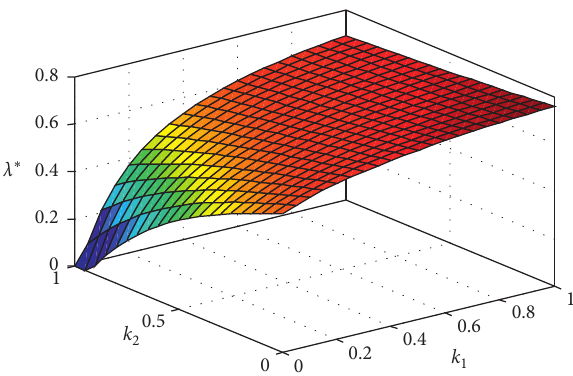
Figure 4: Relationship between the profit sharing coefficient λ ∗ and fairness concern behavior of both parties.